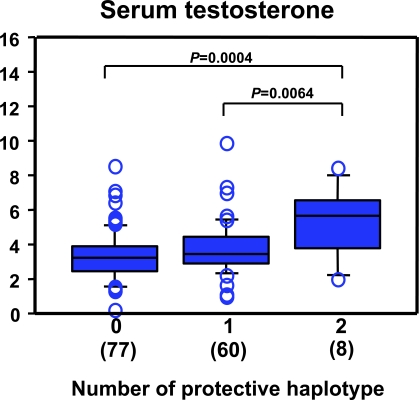
Diplotype-Specific Differences in Serum Testosterone Levels in NOA PatientsThree diplo-groups (code 0, 1, and 2) were defined by the number of ART3 haplotype H1 carried. The serum testosterone levels were significantly different among the three groups (Kruskal-Wallis; df = 2, p = 0.0093) by Bonferroni/Dunn post hoc test.